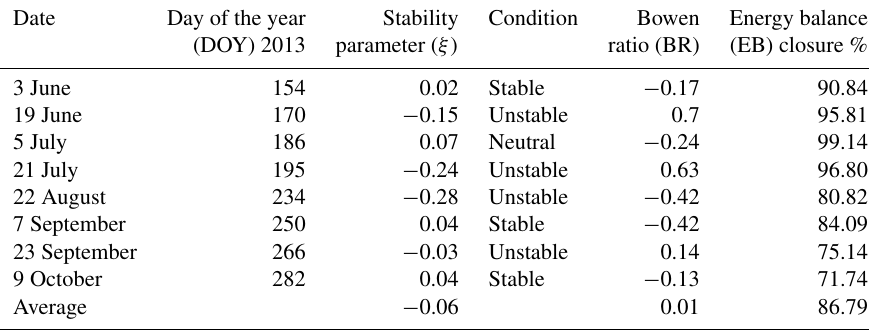
Table 2. Energy balance (EB) analysis of EC measured heat fluxes. Date Day of the year Stability Condition Bowen Energy balance